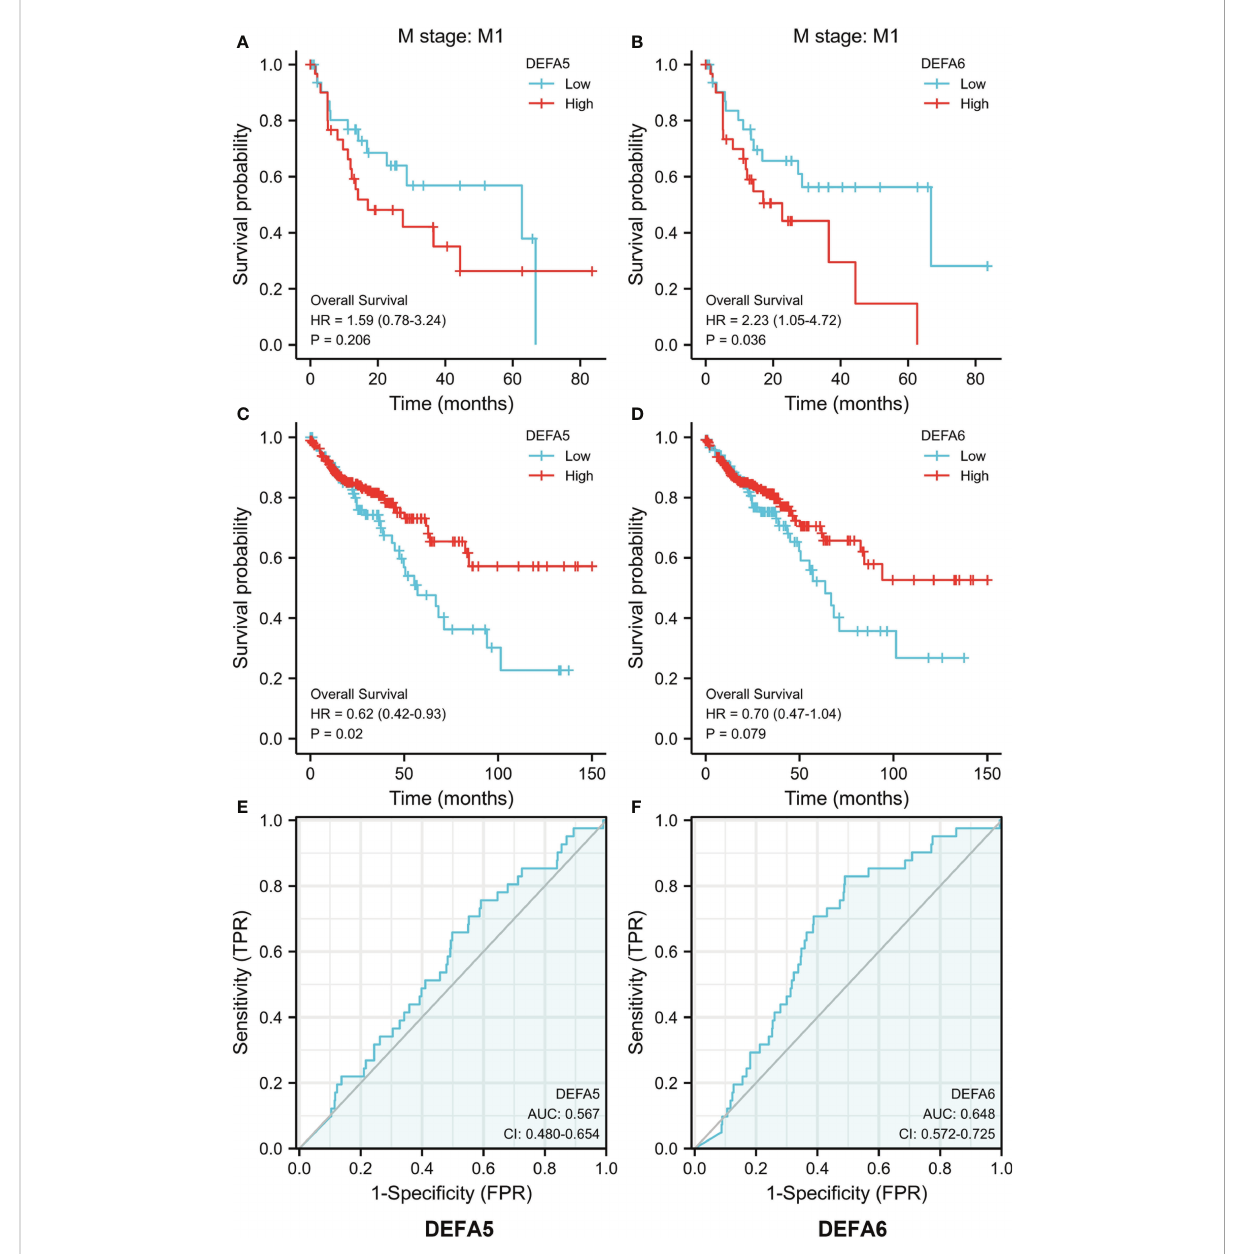
FIGURE 7 The prognostic value of DEFA5 and DEFA6 in patients with CRC. (A) . Correlation between DEFA5 and overall survival of patients with CRC; (B) Correlation between DEFA6 and overall survival of patients with CRC; (C) Correlation between DEFA5 and overall survival of M1 stage patients with CRC; (D) Correlation between DEFA6 and overall survival of M1 stage patients with CRC; (E) ROC Curves of DEFA5 in patients with CRC; (F) ROC Curves of DEFA6 in patients with